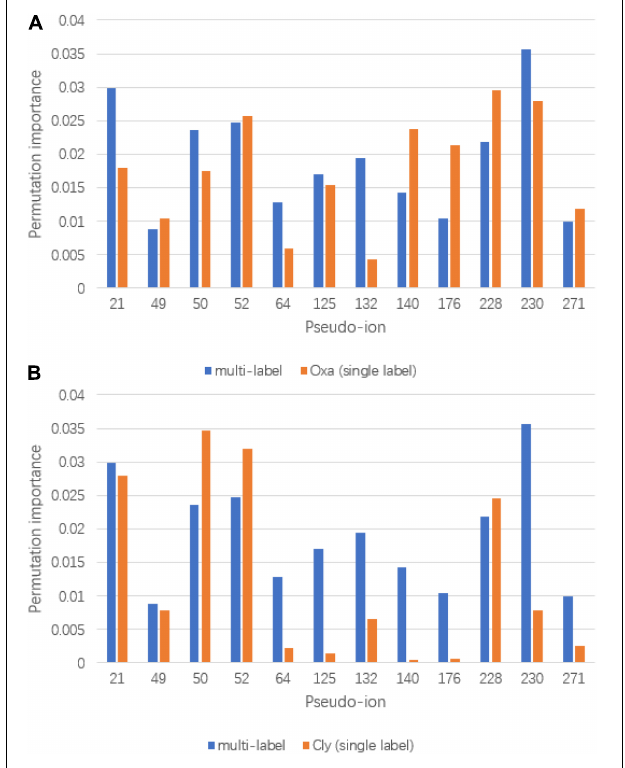
FIGURE 6 | Significant permutation importance comparison between multi-label learning model and single label learning model. (A) Permutation importance comparison for oxacillin susceptibility prediction and (B) permutation importance comparison for clindamycin susceptibility